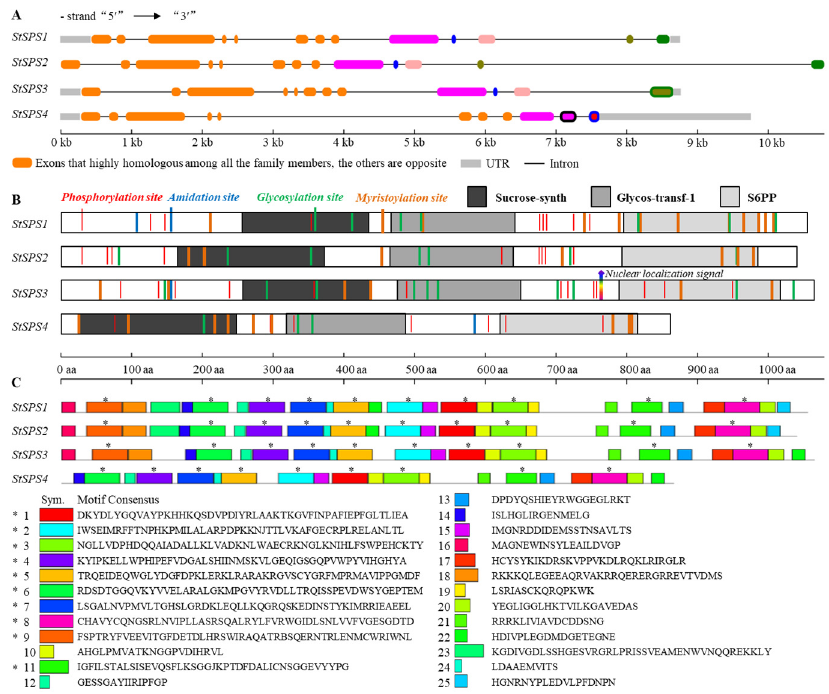
Figure 1. Analysis of the gene and protein structures of StSPS family proteins. ( A ) Gene structure of the StSPS family genes. ( B ) Typical domains and functional sites of StSPS family proteins. ( C ) Prediction of conserved motifs of StSPS family proteins. ‘*’ represents a conservative motif that has been annotated in the database.